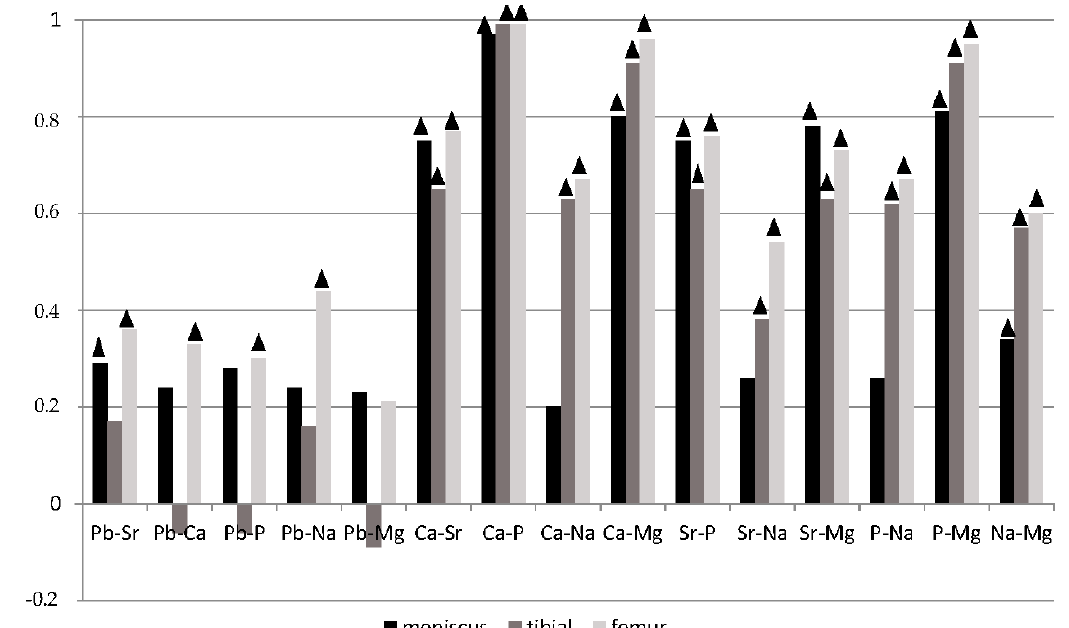
Figure 1. The Spearman’s correlation coefficients for strontium, lead, magnesium, sodium, phosphorus and calcium in tissues of the knee joint ( (cid:78) correlation statistically significant p < 0.05).